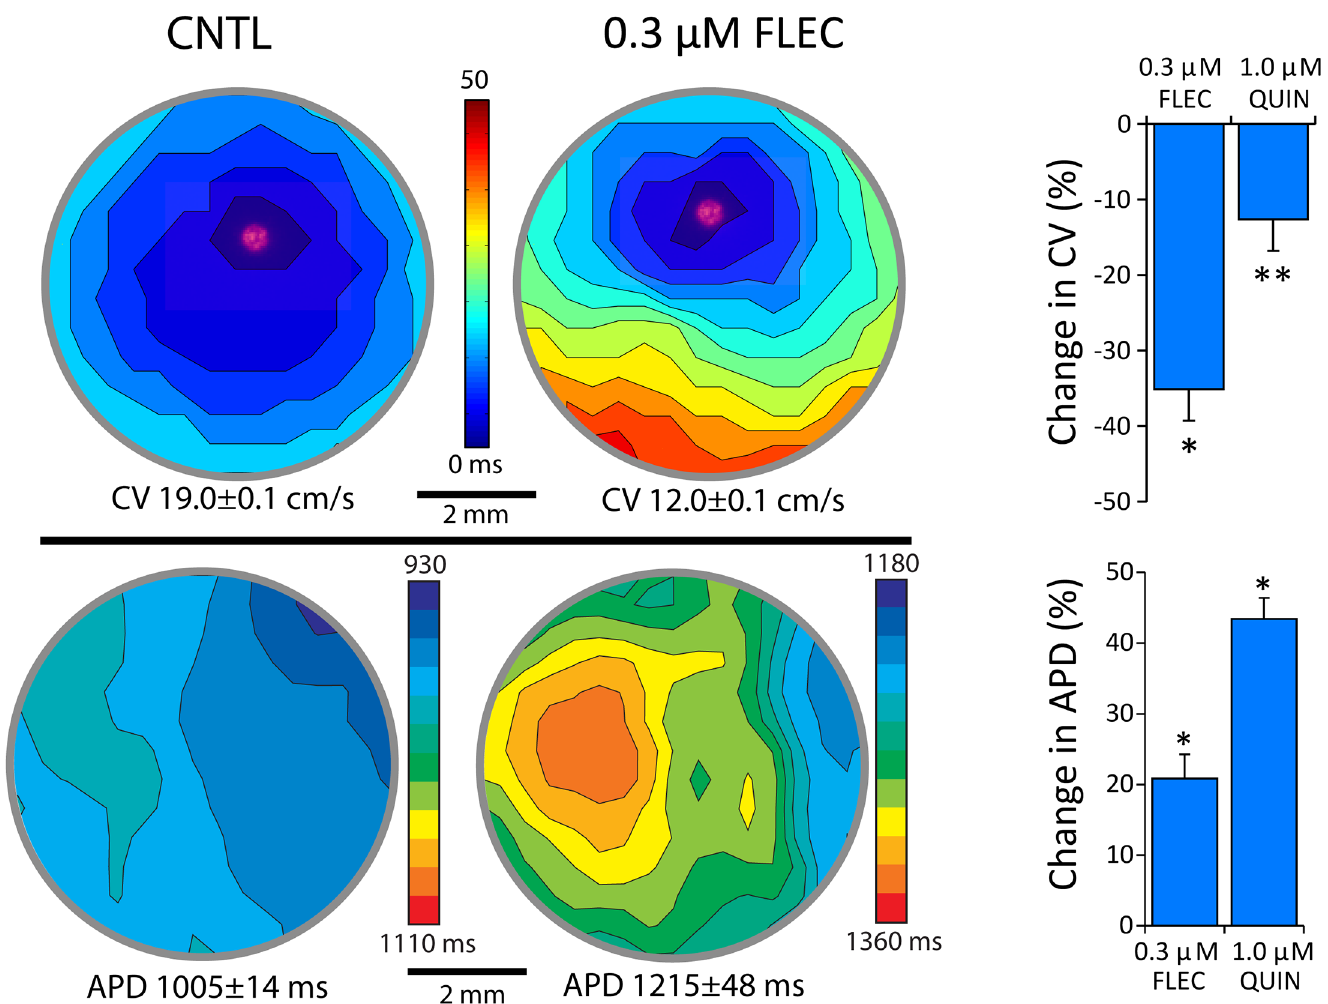
Fig 7. System validation using Flecainide and Quinidine. Activation time (top) and APD (bottom) contour maps measuredat baseline(left) and after 0.3 μ M Flecainide (right) in a singlewell of a 96-wellplate. Mean local conductionvelocity and APD for each map are shown below. Site of opticalpacing is shown by red spot in activationcontours. Flecainide decreased conductionvelocity and increasedAPD. To the right are summary data for mean local conductionvelocity (top) and APD (bottom) before (CNTL) and after Flecainide(n = 7, n = 6) and Quinidine(1.0 μ M, n = 7).